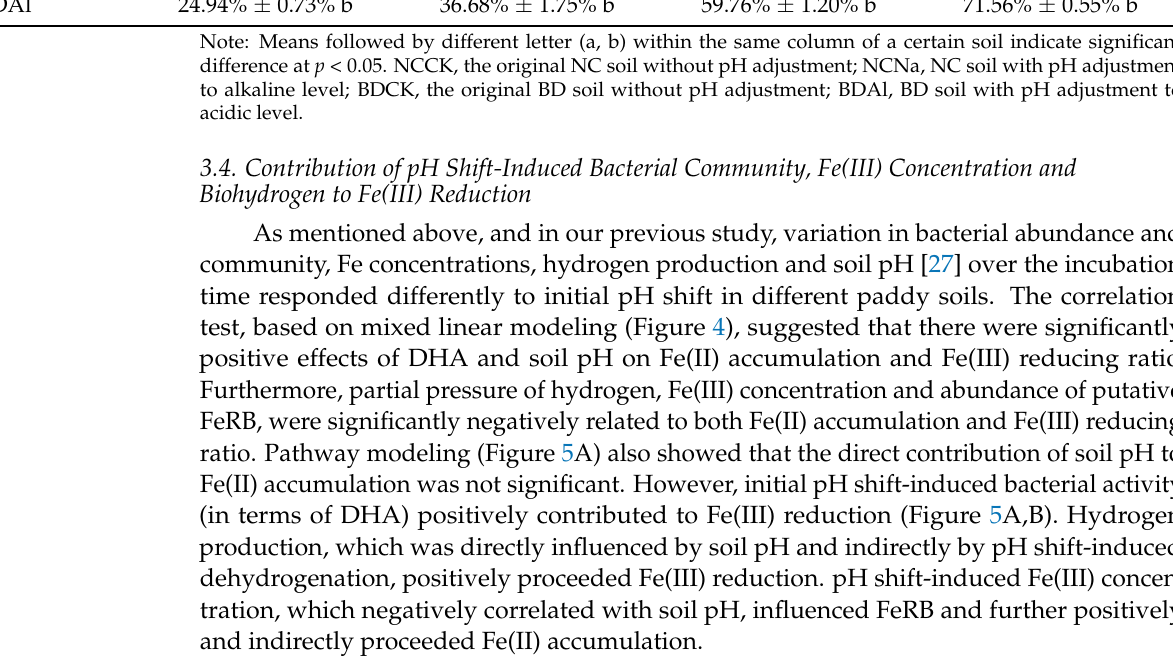
Figure 5. Structural equation modelling analysis embedding of mixed effect liner modelling ( A ) and redundancy analysis (RDA) triplot ( B ) to investigate the relationship between pH shift-mediated Fe(III) reduction and associated fermentative processes as well as succession of putative Fe(III) re- ducing bacteria (FeRB). (DHA, dehydrogenase activity; H 2 , partial pressure of hydrogen; Putative